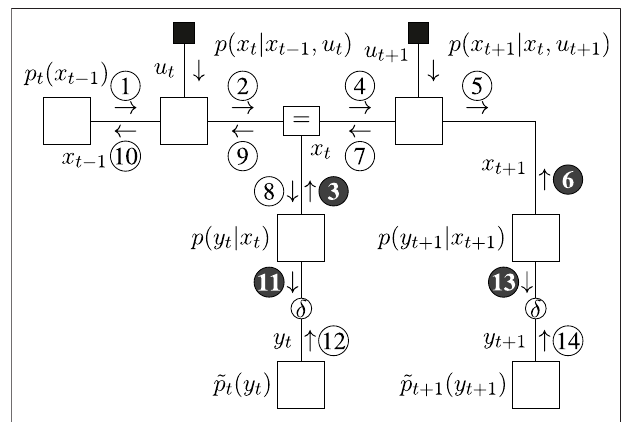
FIGURE 5 | Message passing schedule for planning in the T-maze with the BFE. FIGURE 6 | Message passing schedule for planning in the T-maze with